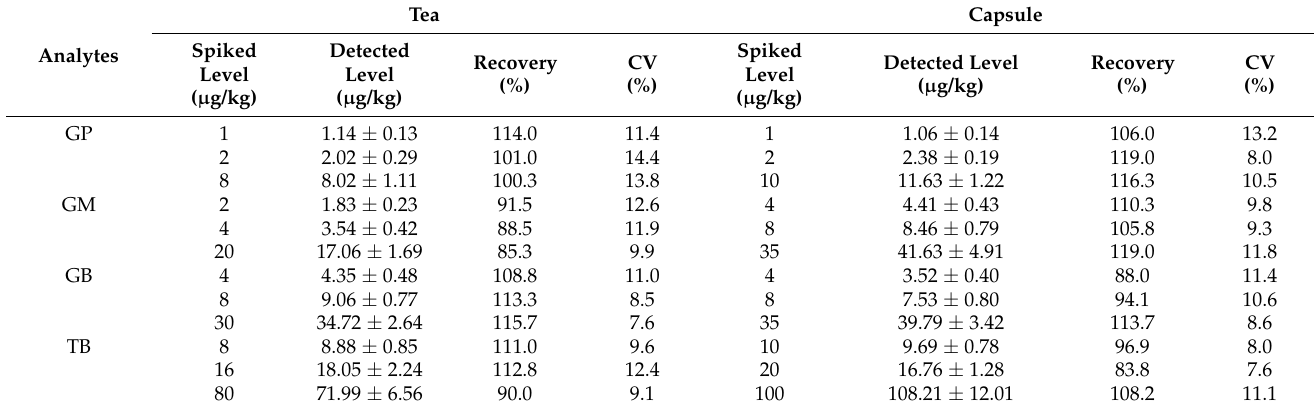
Table 1. Recovery of SUs in functional tea and capsule by PCN-224@PDA-LFIA (n =